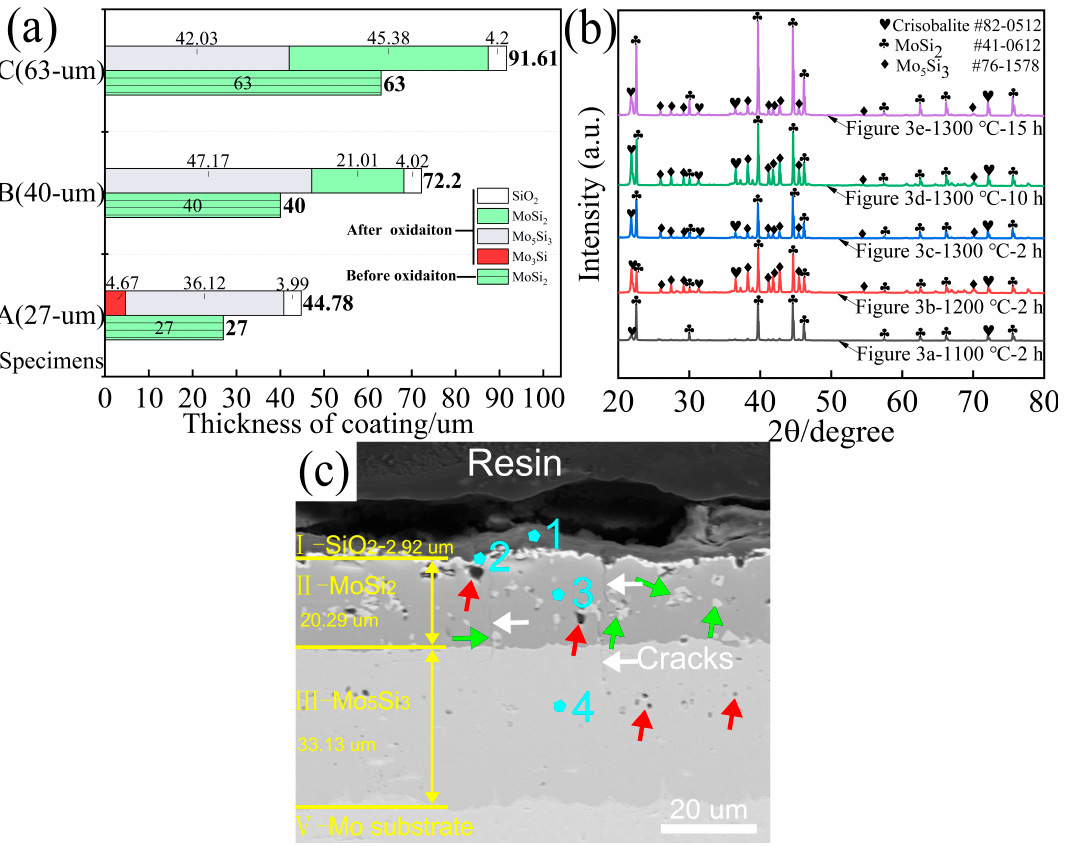
Figure 1. ( a ) The thickness change of different coatings at 1300 ◦ C for 20 h; ( b ) XRD patterns of preoxidation specimens; ( c ) The cross-sectional BSE image of as-oxidized specimen at 1300 ◦ C for 10 h. After oxidation, a typical cross-sectional BSE image of specimens at 1300 ◦ C for 10 h is presented in Figure 1c. The whole coating is relatively uniform and dense. Due to different diffusion coefficients of Mo and Si [17], the mutual diffusion results in the formation of Kirkendall effect pores shown in red arrows. In addition, a few cracks (white arrows) are generated as a result of thermal expansion coefficient (CET) mismatch (MoSi 2 , to room temperature. According to EDS analysis (Table 2. spot1, 2, 3, 4) and XRD pattern (Figure 1b), the multilayer structure is composed of 2.92 µ m SiO 2 , 20.29 µ m MoSi 2, and 33.13 µ m Mo 5 Si 3 . The SiO 2 layer forms on the surface of specimens as a result of the oxidation reactions [19]. The oxidation reactions are described as the follows: MoSi 2 + 7/2O 2 = MoO 3 + 2SiO 2